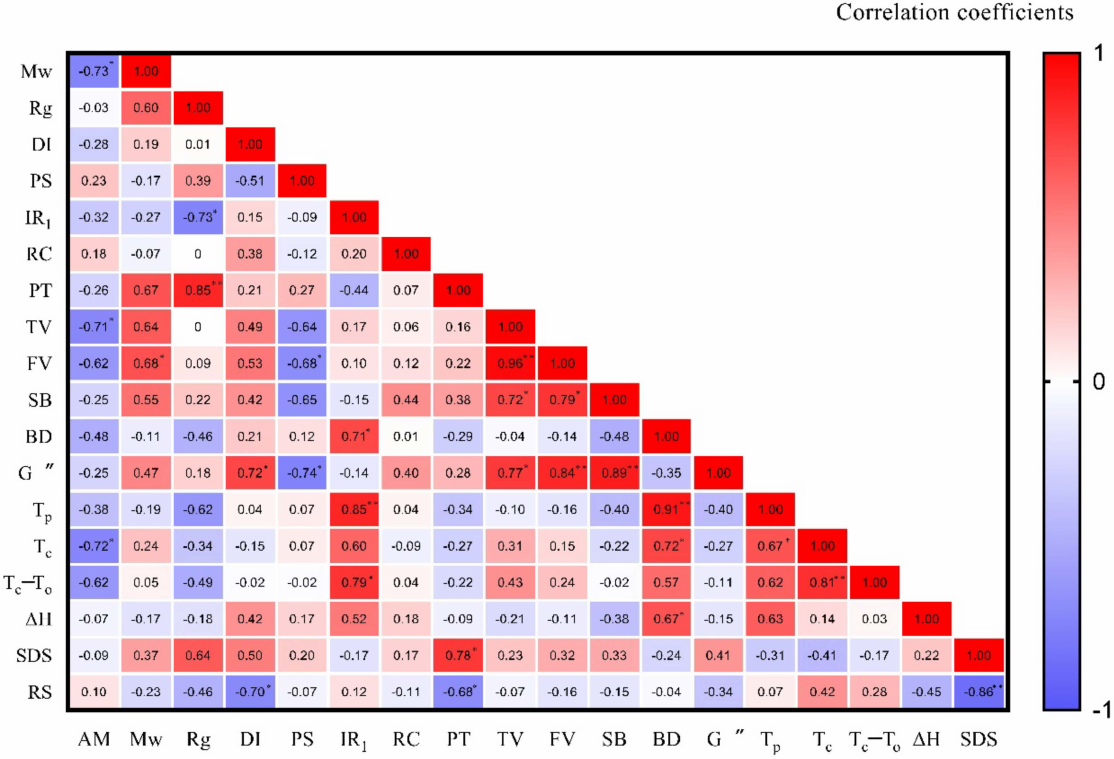
Figure 6. Pearson correlation coefficients between the structures and properties of yam